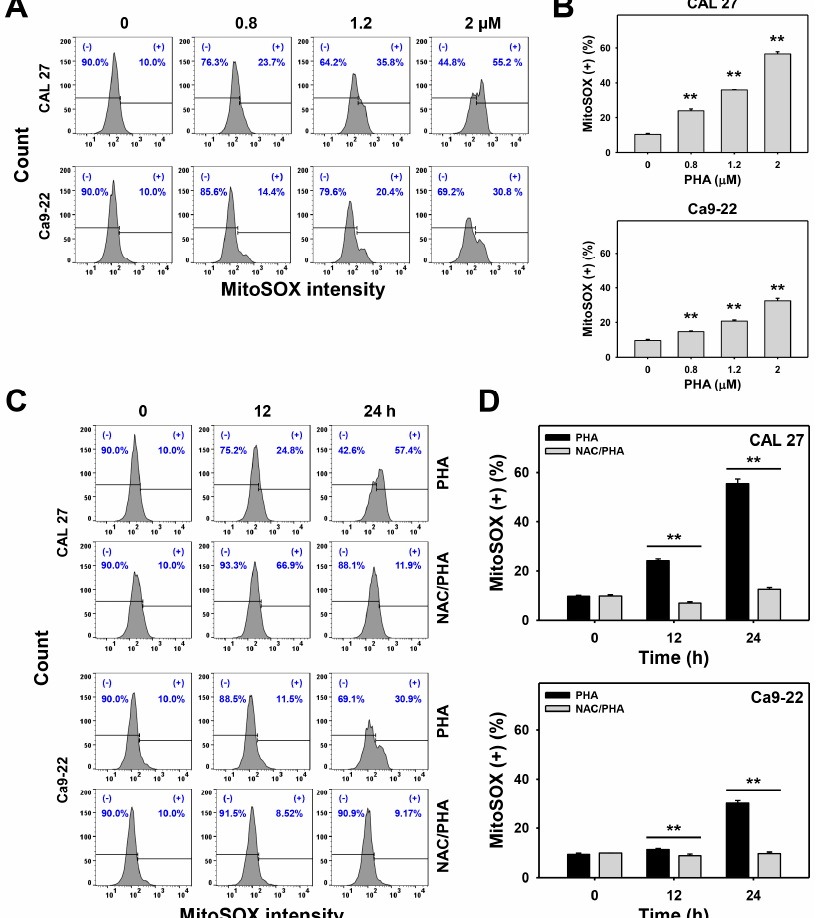
Figure 6. PHA enhances MitoSOX intensity in oral cancer cells. ( A , B ) MitoSOX analysis. Cells were exposed to 0 (0.1% DMSO medium as control), 0.8, 1.2, and 2 μ M PHA for 24 h. The (+) population was counted for MitoSOX (+) (%). ( C , D ) Suppression of PHA-induced MitoSOX by NAC. To evaluate the recovery effect of NAC, NAC (10 mM for 1 h) was added to cells before 12 and 24 h treatment with PHA (control (0.1% DMSO medium) and 2 μ M), i.e., NAC/PHA. Data, means ± SDs ( n = 3 independent experiments); ** indicates p < 0.001.